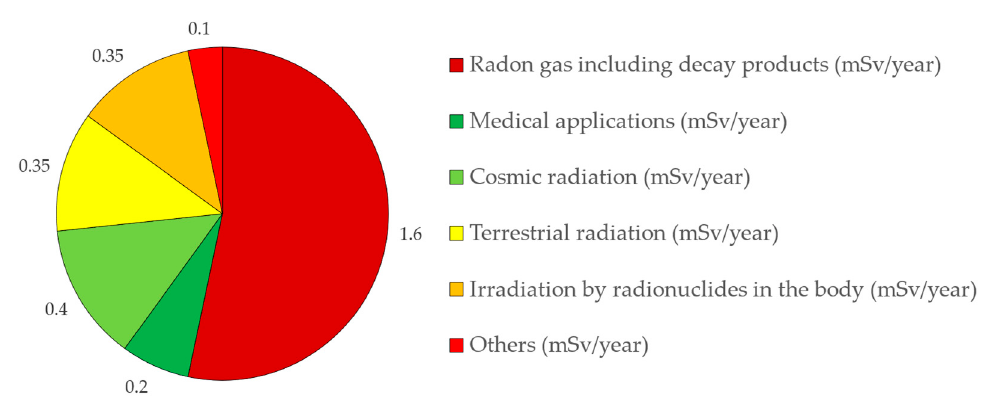
Figure 3. Most representative origins of exposure of the world population to ionizing radiation (adapted from [91] ).